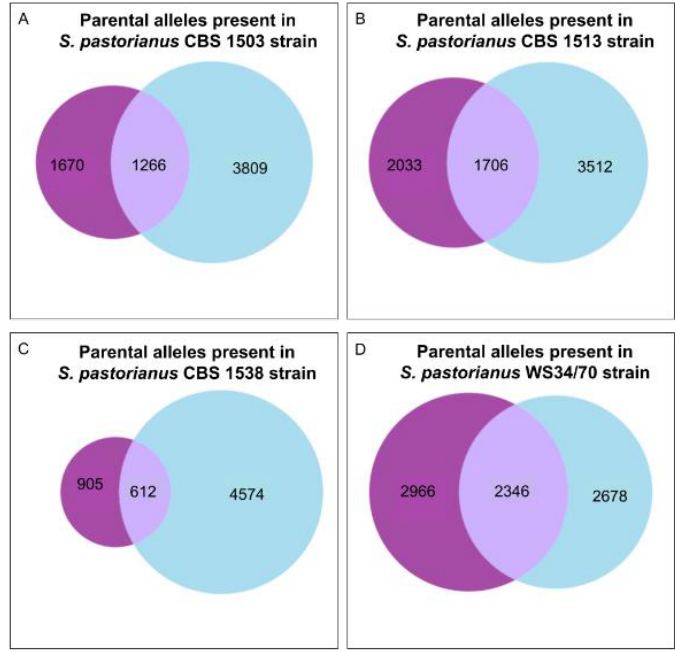
Figure 7. Venn diagrams showing the inherited S. eubayanus-like and S. cerevisiae-like parental alleles that have a unique function, represented in light blue and purple circle, respectively; and in the intersection those the parental ortholog alleles that share the same function. ( A ): S. pastorianus CBS1503. ( B ): S. pastorianus CBS1513. ( C ): S. pastorianus CBS1538. ( D ): S. pastorianus WS34 / 70.